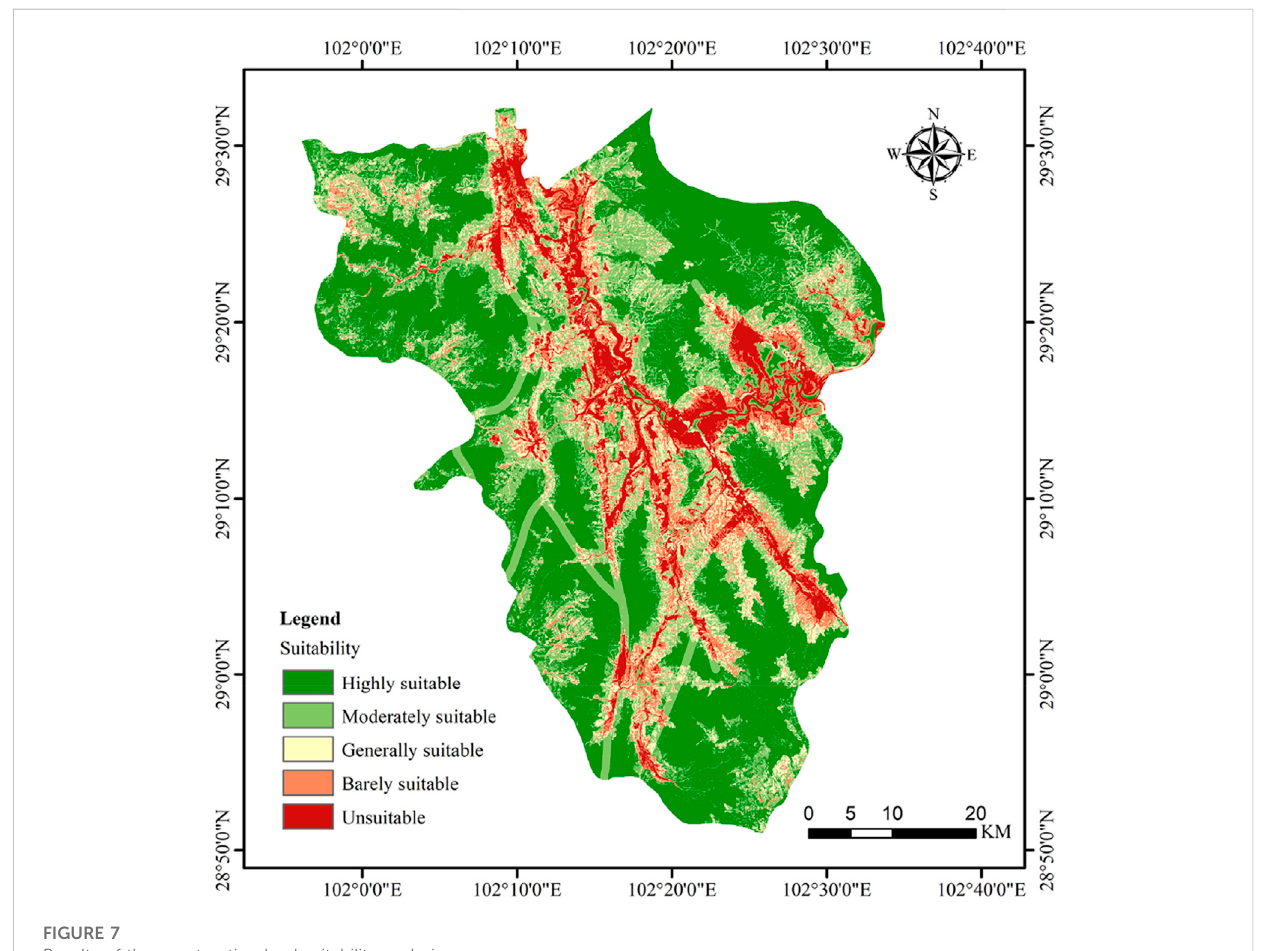
FIGURE 7 Results of the construction land suitability